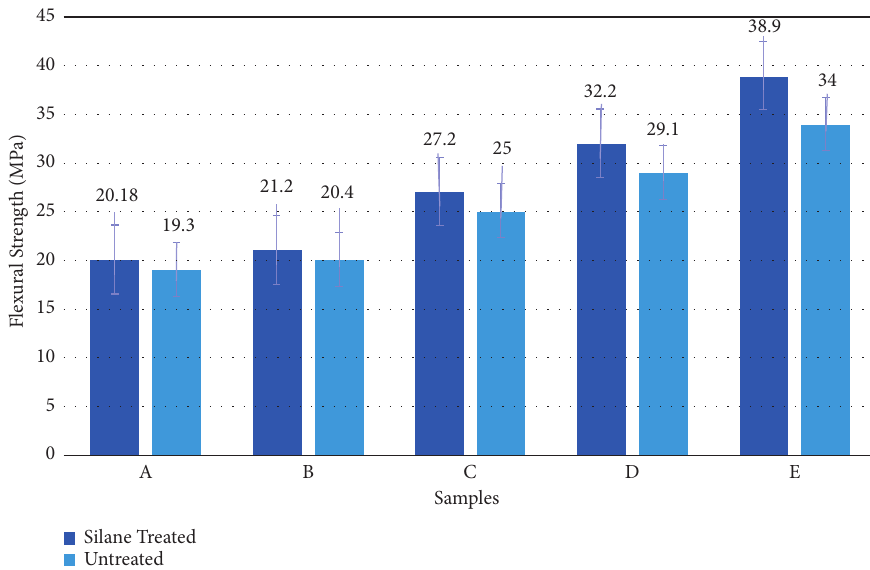
Figure 5: Flexural strength of the hybrid epoxy